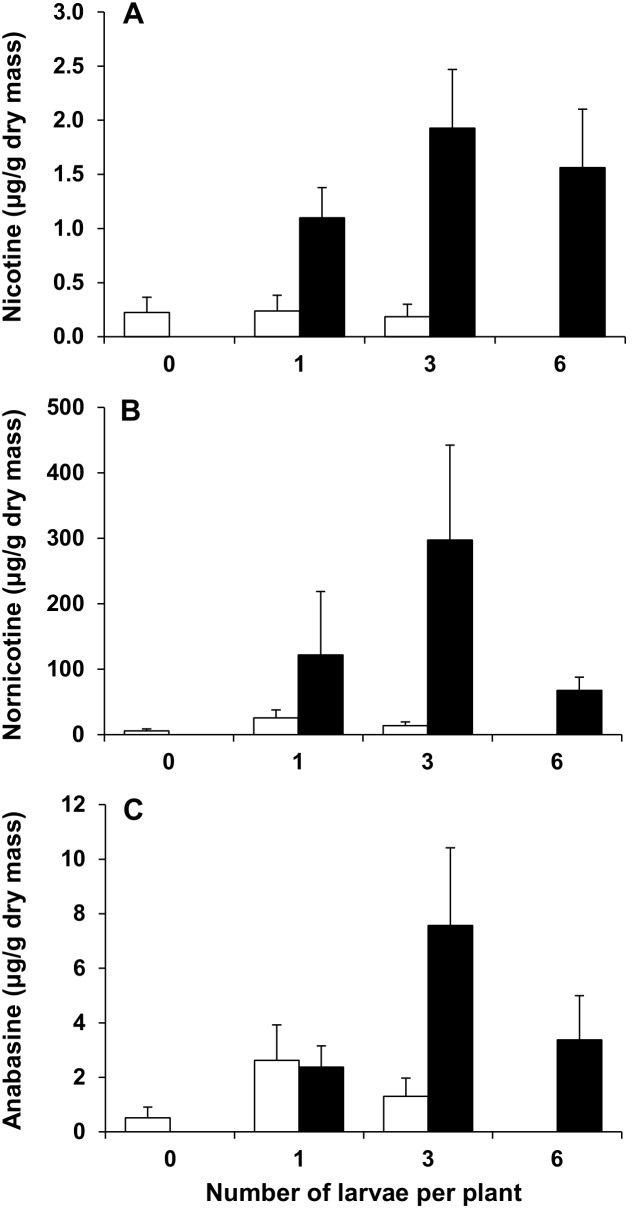
Effect of herbivory on leaf alkaloid concentrations.Effect of herbivory by Helicoverpa armigera fourth-instar larvae on (A) nicotine, (B) nornicotine and (C) anabasine concentrations (mean ± SE) in undamaged (open bars) and herbivore damaged (black bars) middle leaves of flowering Nicotiana africana plants. n = 4–30.